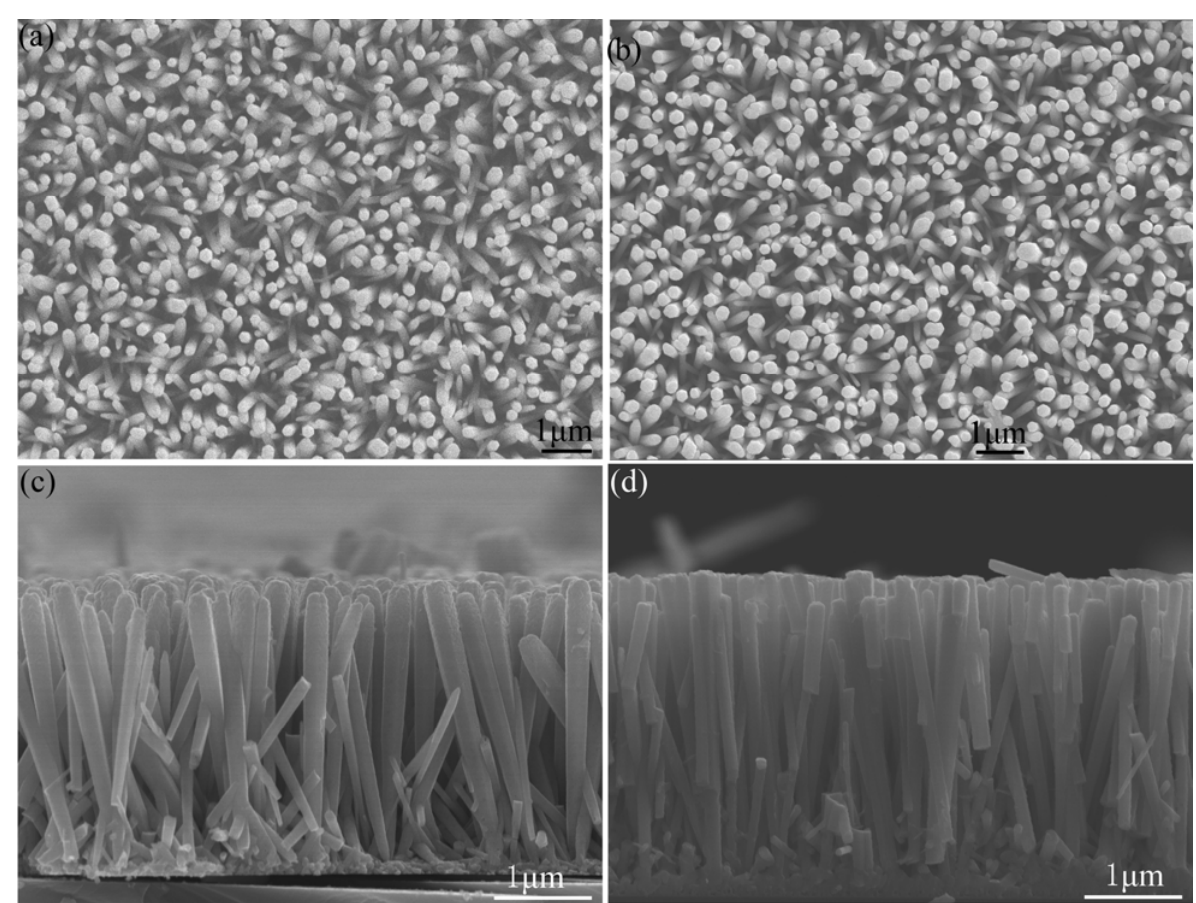
Figure 8. Top view SEM images of ( a ) as-grown ZnO nanorods and ( b ) LSMO coated on ZnO nanorods by sputtering. Cross sectional SEM image of LSMO coated around ZnO nanorods ( c ) by sputtering, and ( d ) by colloidal